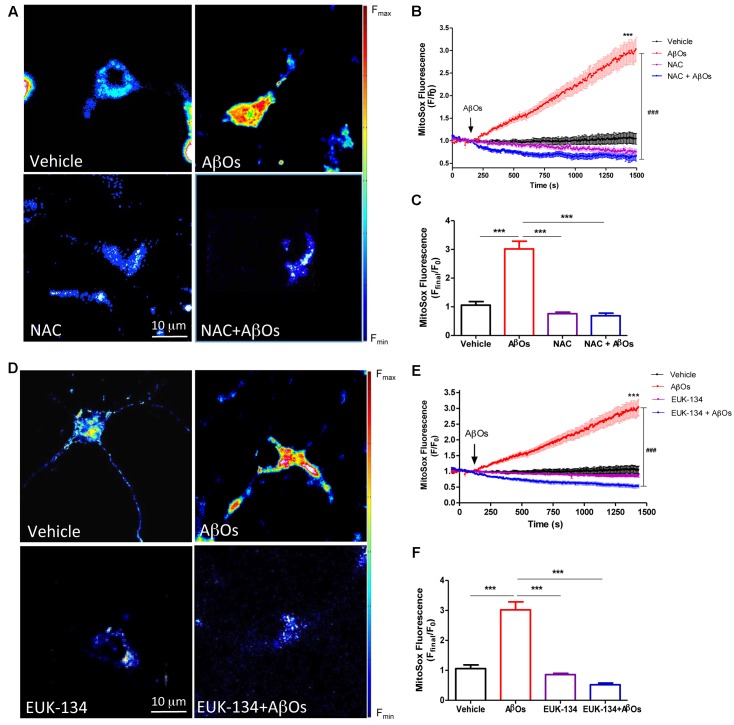
The antioxidants NAC and EUK-134 prevent mitochondrial superoxide generation induced by AβOs.
(A) Hippocampal neurons, pre-incubated with 10 mM NAC for 30 min, were loaded next with MitoSOXTM and treated with 500 nM AβOs or vehicle at the microscope stage. Pseudocolor images of MitoSOXTM fluorescence in confocal sections obtained at the end of the experiment (1500 s). The scale bar corresponds to 10 μm. In the pseudo color rainbow scale (right), “warmer” colors correspond to higher fluorescence. (B) MitoSOXTM fluorescence recorded as a function of time in neurons kept in vehicle (black trace), in neurons treated with AβOs (red trace), in neurons pre-incubated with NAC and kept in vehicle (pink trace) or treated with AβOs (blue trace). Changes in fluorescence, plotted as signal over time with respect to the baseline fluorescence (F/F0), were expressed as mean ± SE. Arrow indicates the time of AβOs additions. (C) Changes in MitoSOXTM fluorescence were plotted as the signal obtained at the end of the experiment (1500 s) with respect to the baseline fluorescence (Fend/F0) and were expressed as mean + SE for all experimental conditions. (D) Neurons were pre-incubated with 20 μM EUK-134 for 2 h, then loaded with MitoSOXTM and treated with 500 nM AβOs or vehicle at the microscope stage. Pseudocolor images of MitoSOXTM fluorescence were acquired as in (A). (E) MitoSOXTM fluorescence recorded as a function of time in neurons kept in vehicle (black trace), in neurons treated with AβOs (red trace), in neurons pre-incubated with EUK-134 and kept in vehicle (pink trace) or treated with AβOs (blue trace). Changes in fluorescence, plotted as signal over time with respect to the baseline fluorescence (F/F0), were expressed as mean ± SE. Arrow indicates the time of AβOs additions. (F) Changes in MitoSOXTM fluorescence were plotted as the signal obtained at the end of the experiment (1500 s) with respect to the baseline fluorescence (Fend/F0) and expressed as the mean + SE, for all the experimental conditions. For each condition, ROIs were defined in 1 to 3 neurons per field, in order to monitor the production of superoxide levels. (n = 21 for control, n = 31 for AβOs, n = 8 for NAC + AβOs, n = 12 for NAC), n = 16 for EUK-134 + AβOs, n = 20 for EUK-134). Statistical analysis was performed using one-way ANOVA followed by Bonferroni post hoc test. ∗∗∗p < 0.001 compared with control. ###p < 0.001 compared to AβOs-treated neurons.